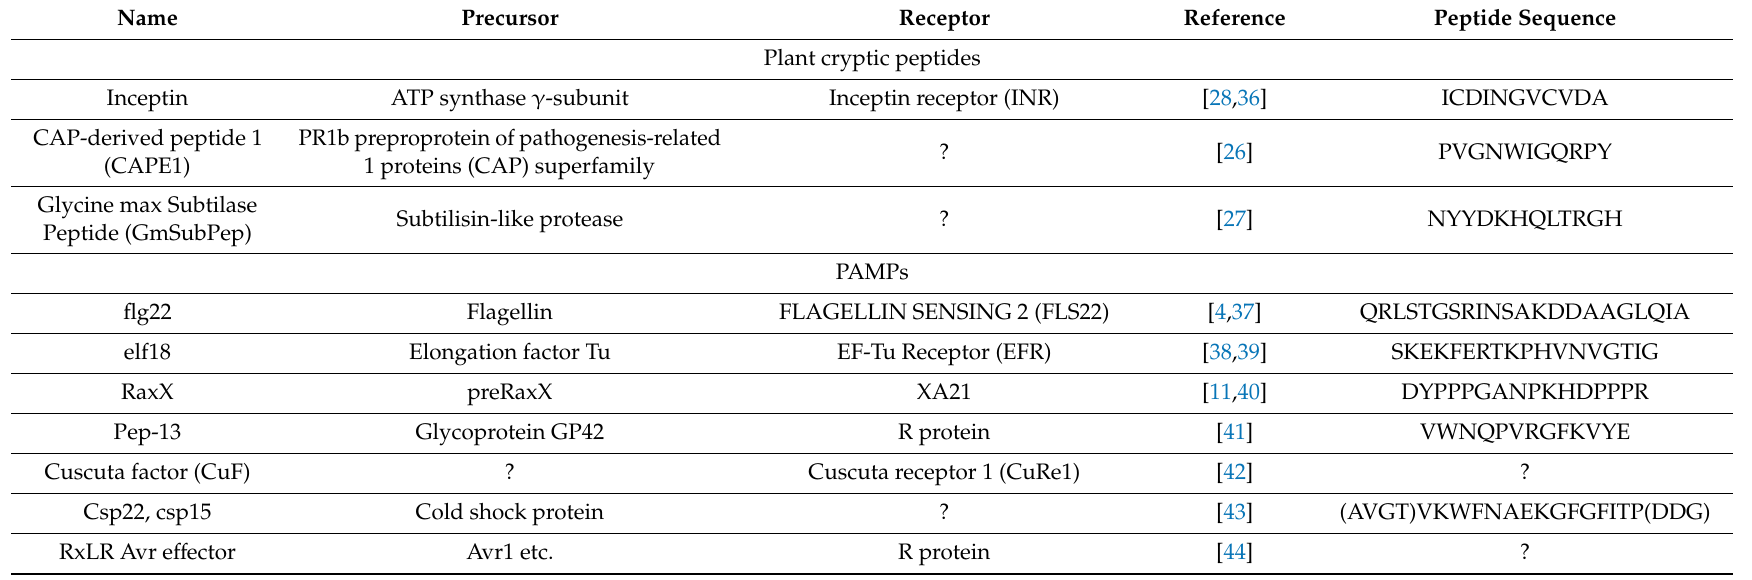
Table 1. Cryptic immune